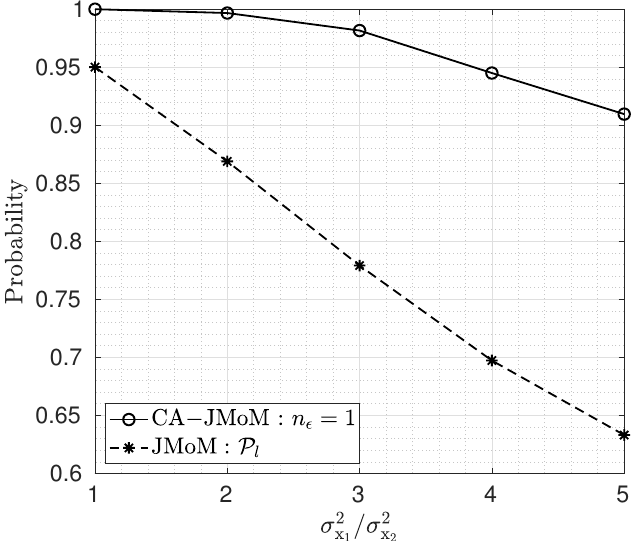
Figure 8. Lock-in probability versus power ratios of users.